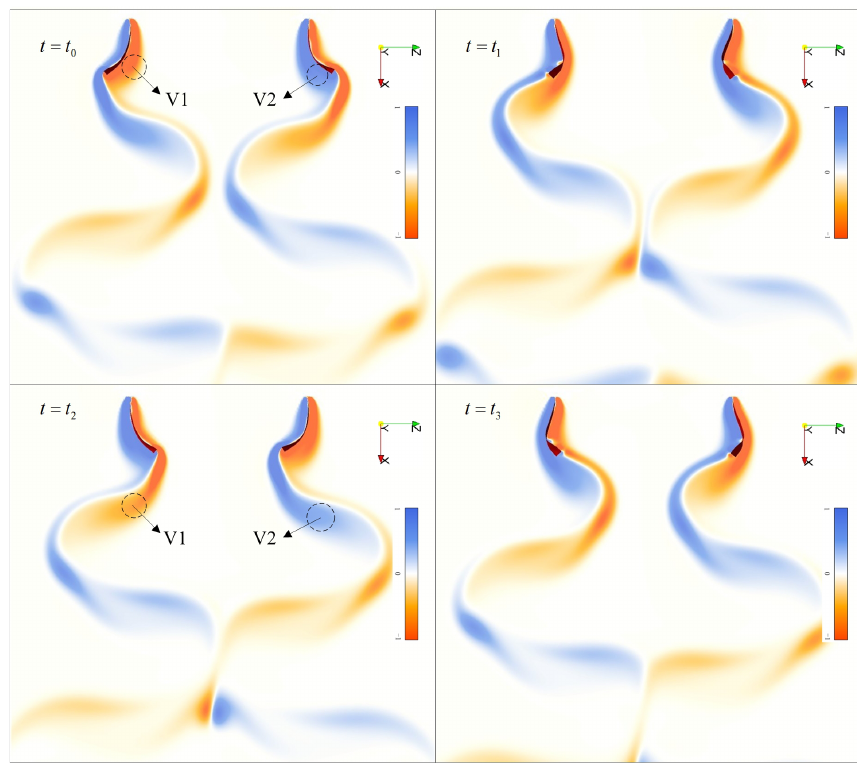
Figure 14. Time evolutions of the vortical structures of two side-by-side flapping plates at G z =